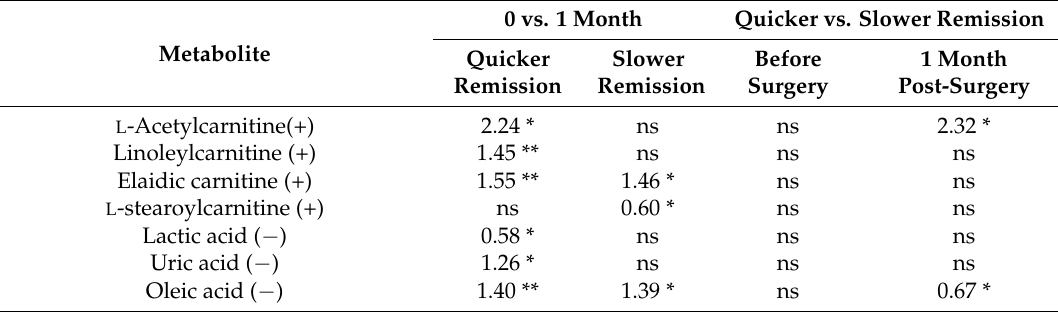
Table 3. Metabolites discriminating quicker and slower T2DM remission groups detected with LC-MS. 0 vs. 1 Metabolite